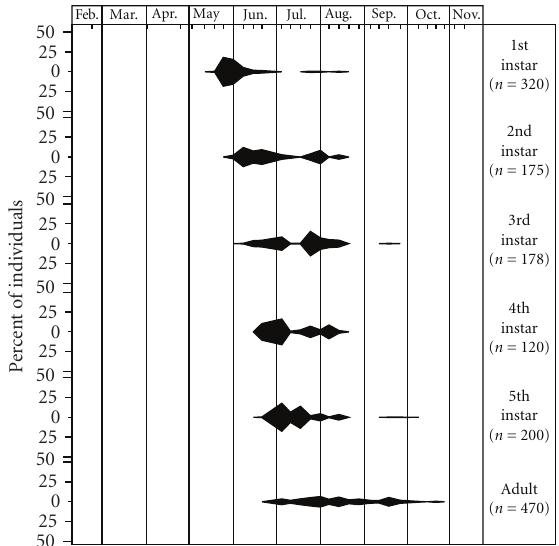
Figure 2: Percent of individuals of Metrobates hesperius of same stage across all sample